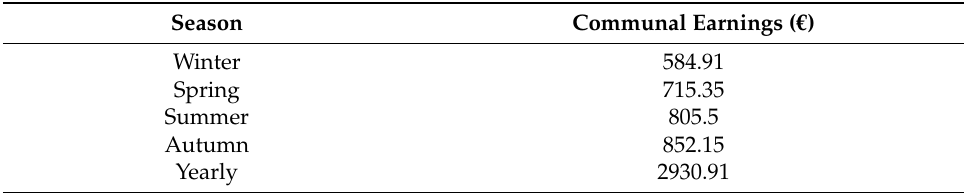
Table 6. Earnings of communal assets each season.